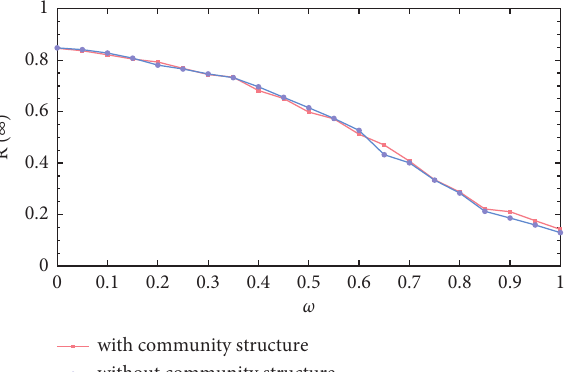
Figure 8: The final density of recovered individuals in the physical layer under different parameters ω for the virtual contact networks with or without community